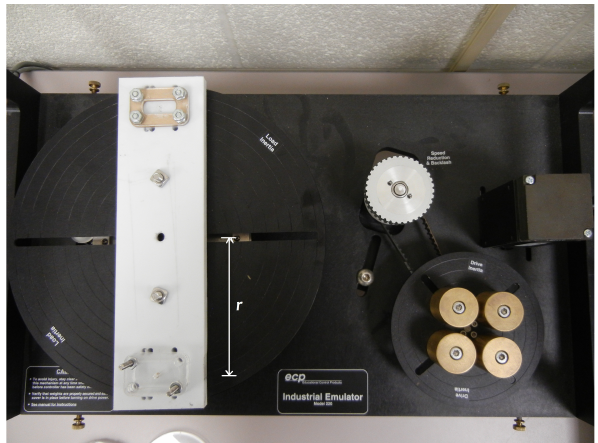
Figure 6. Test setup for applying constant centripetal accelerations.